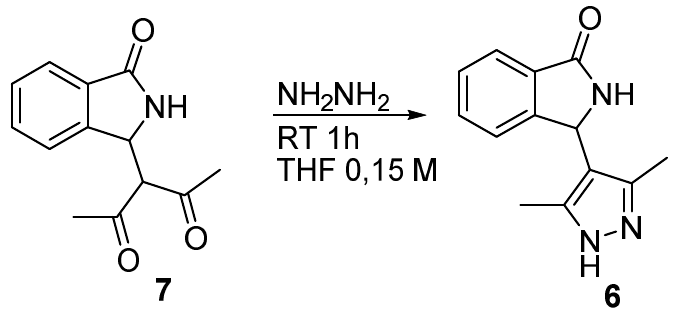
Figure 4. ORTEP drawings for compound (+)- 6 (CCDC 2246867).